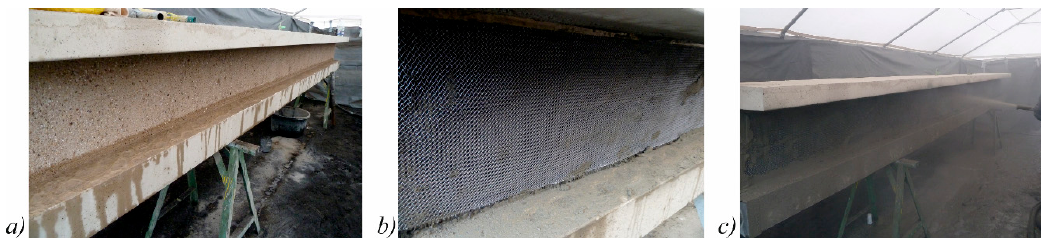
( c ) the application of shotcrete